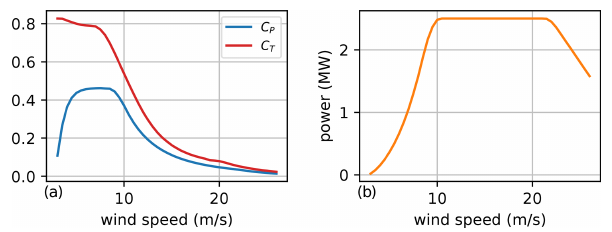
Figure 2. (a) C P and C T curves for the 2.5MW turbine used in this study. (b) The power curve for this same